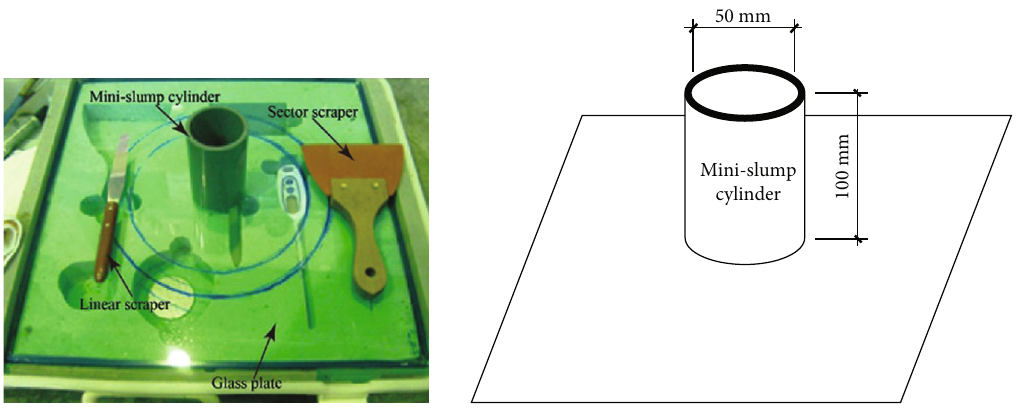
Figure 1: Size and shape of the minislump